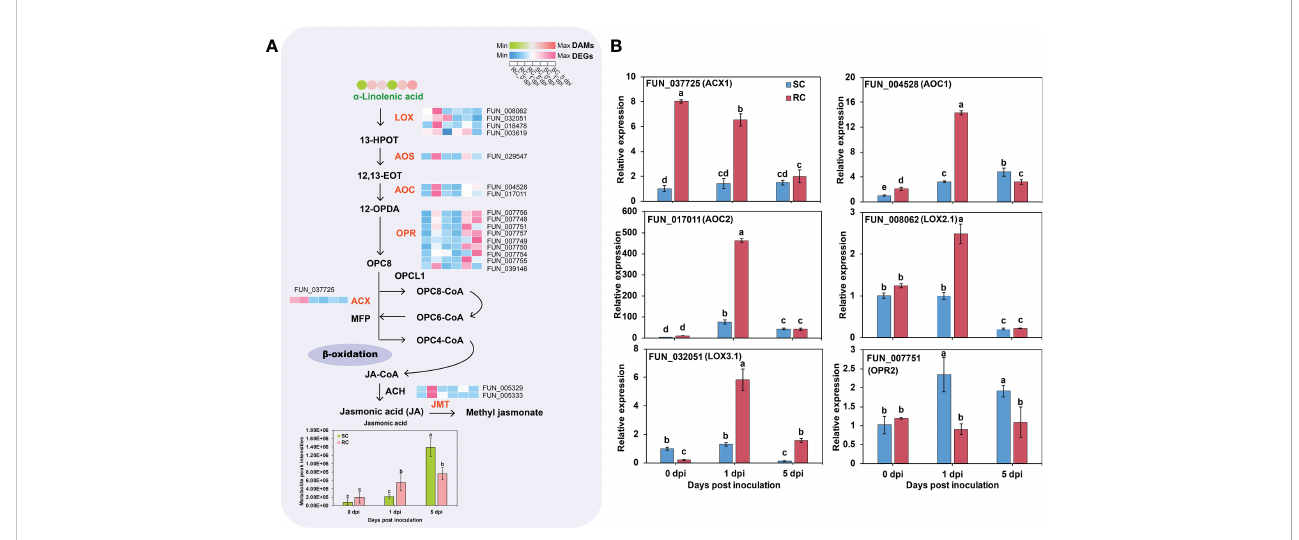
FIGURE 6 Jasmonic acid (JA) synthesis pathway and gene expression analysis. (A) Schematic representation of the core JA synthesis pathway; the circle heat map and the square heat map represent the expression of DAMs and DEGs, respectively, in the SC and RC at the three stages of testing. (B) RT-qPCR analysis of JA synthesis-related genes. Error bars represent standard deviation (n = 3). Different letters above the bars indicate signi fi cant differences at the 0.05 level according to Duncan ’ s multiple range